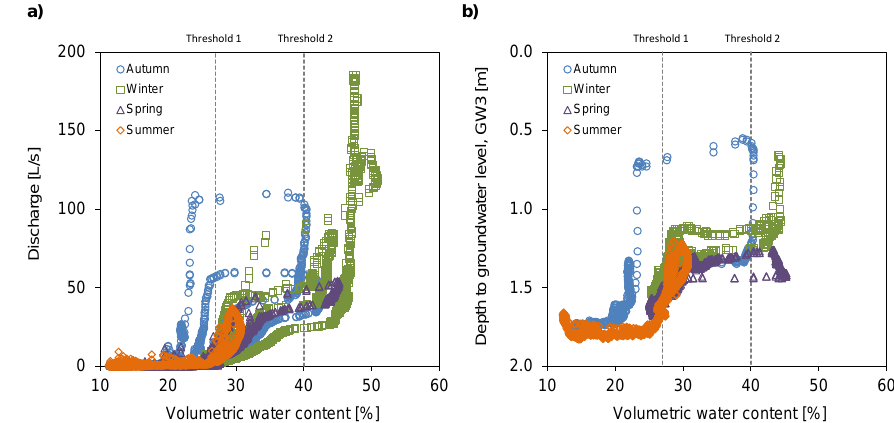
Figure 3. Relationship between (a) volumetric water content (hillslope foot) and discharge, and (b) between volumetric water content and depth to groundwater level for the period plotted in Fig. 2. Vertical dashed lines represent two threshold values (see details in the text).